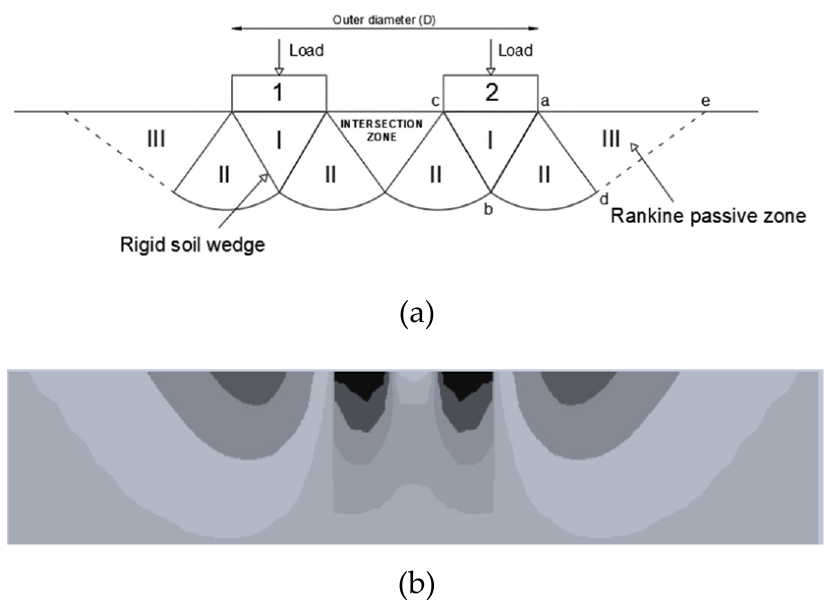
Figure 4. An equivalent of a two-adjacent footing. ( a ) An illustration of intersection zone formed in soil under a ring footing. ( b ) Deformation profiles within soil in response to a load exerted by a ring